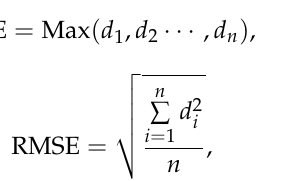
Figure 14. Comparison in elevation between the measured and mapped trajectories in which the ordinate is Z (m), and the abscissa is the video frame number.